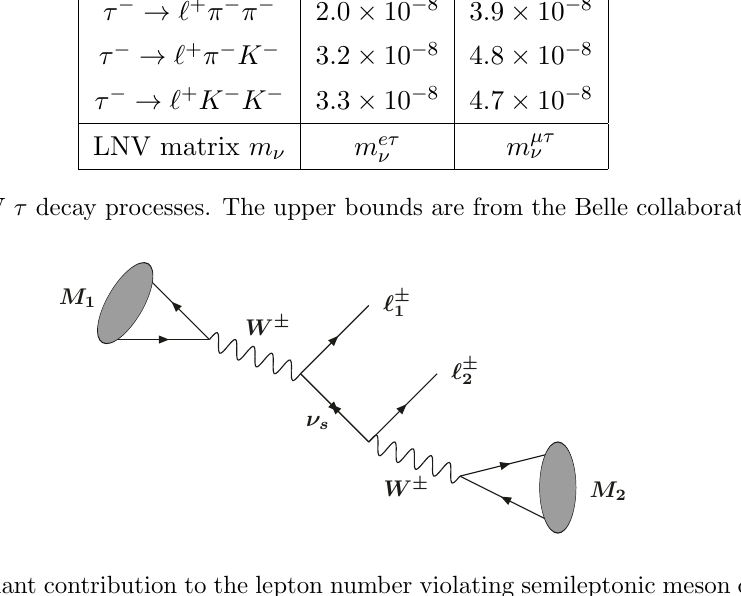
Figure 1 . Dominant contribution to the lepton number violating semileptonic meson decay, M 1